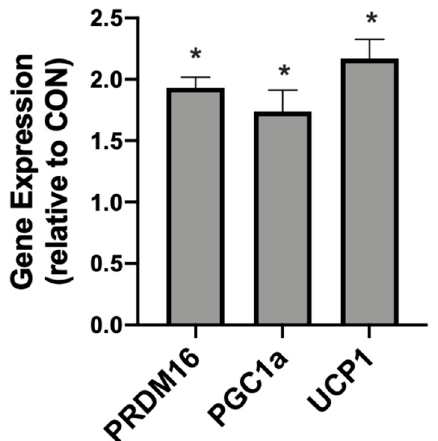
Figure 2. β -hydroxybutyrate ( β HB) alters the mitochondrial-related gene expression in cultured adipocytes. Following treatment with β HB (5 mM; 24 h), the cells were harvested and the expression of PRDM16, PGC1 α , and UCP1 was quantified. n = 6. * p < 0.05.